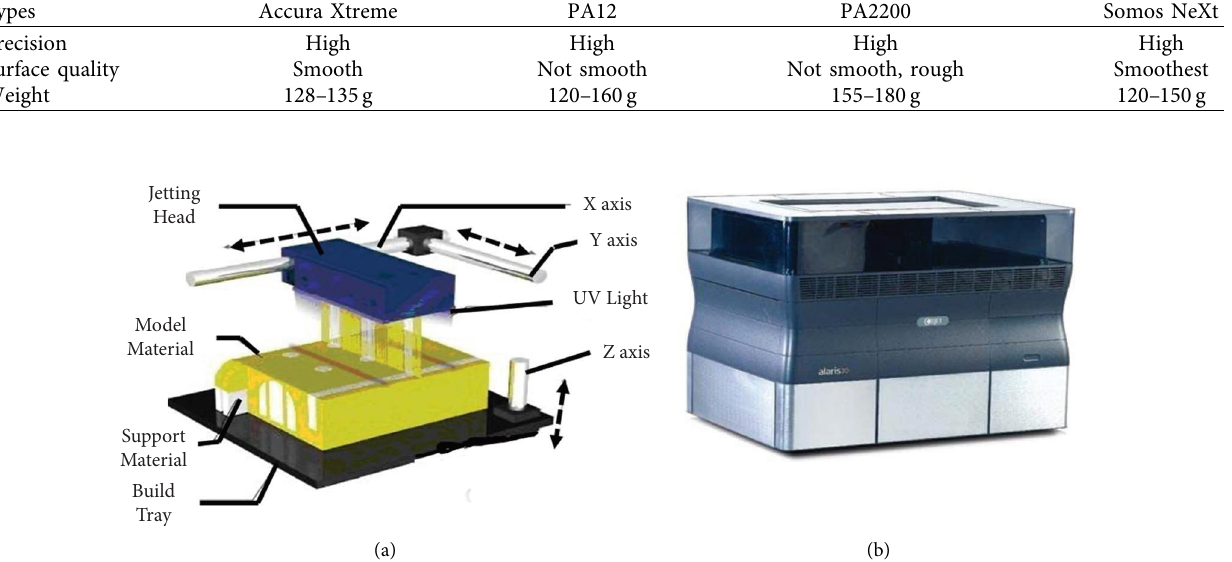
Figure 12: PolyJet printing principle (a) and equipment